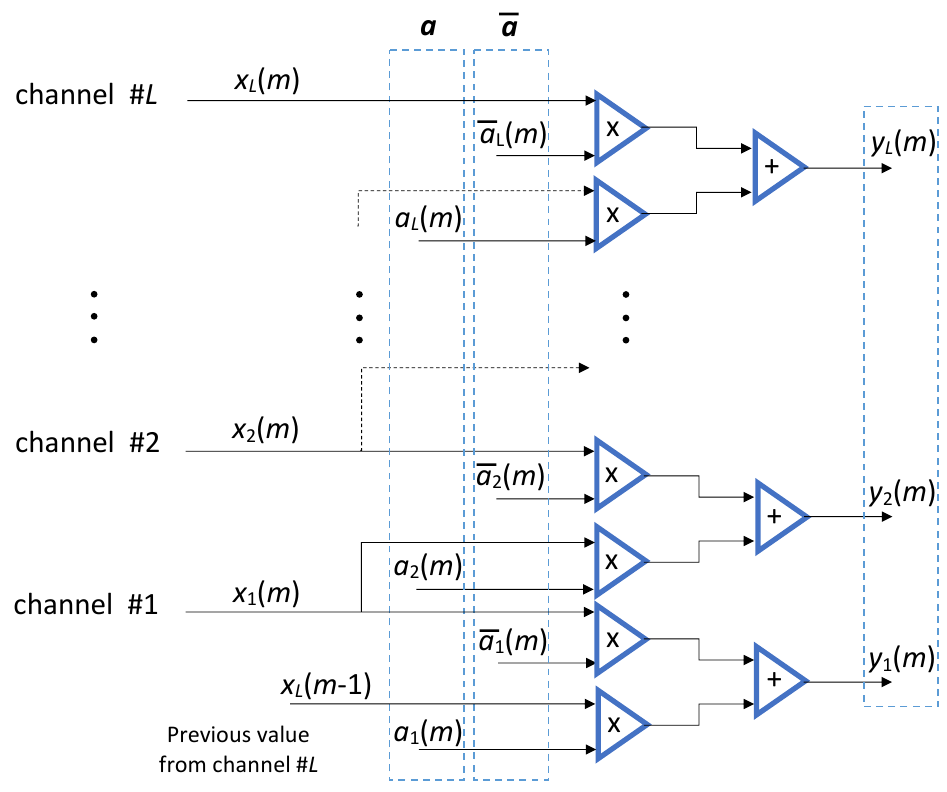
Figure 3. Parallel processing scheme for filtering the bunches produced by the multichannel architec- ture. The coefficients depend on the time variable m and are recalculated at any clock cycle. Useful resampled values are intermingled with dummy values in the output array, y